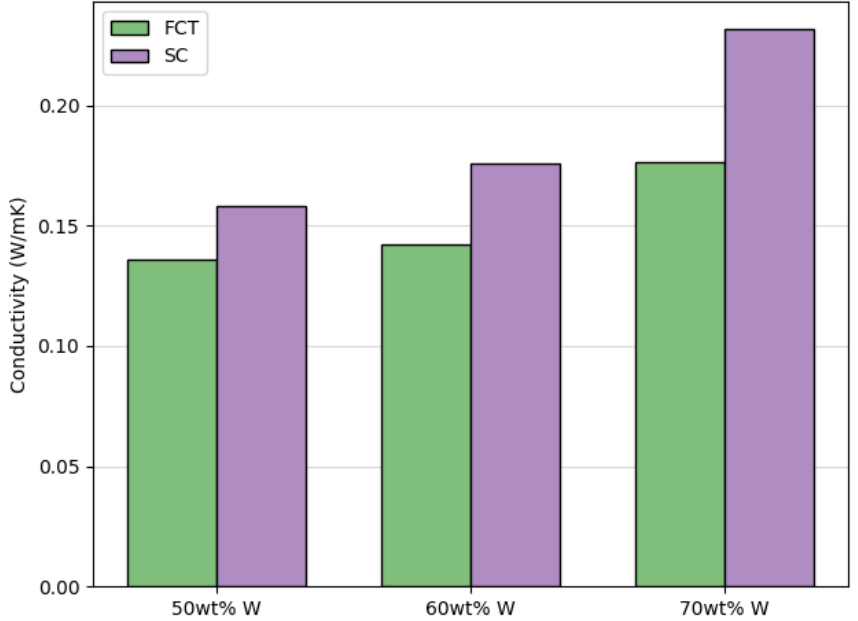
Figure 14. Thermal conductivity of tungsten-filled DIW pads printed with FCT and SC lattice structures with 500 µ m center-to-center strut spacing.